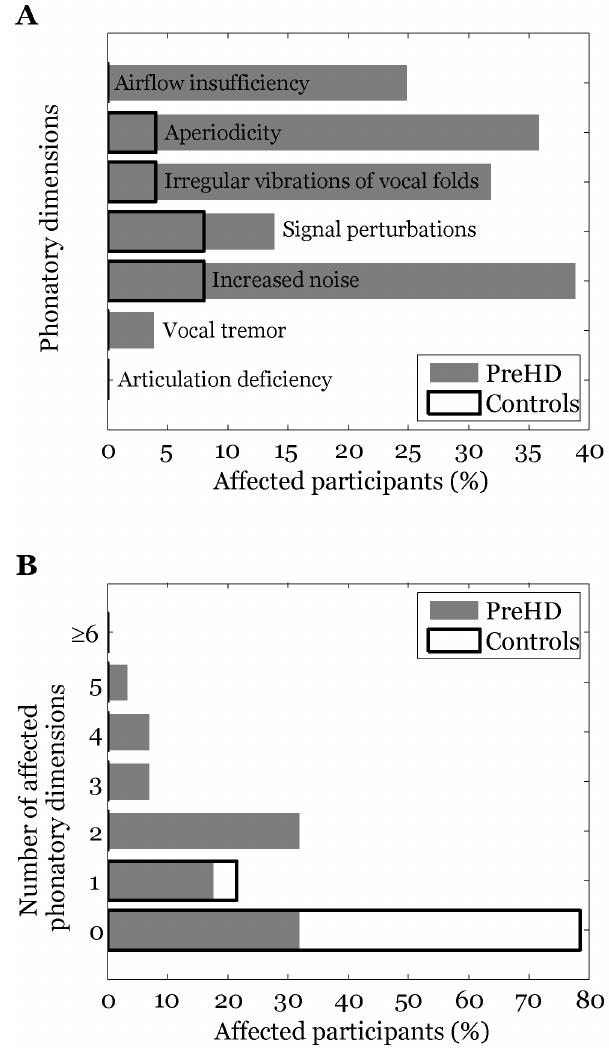
Figure 2. Results of voice analyses: (A) percentage of affected participants according to the specific phonatory dimension; (B) number of affected phonatory dimensions across participants.